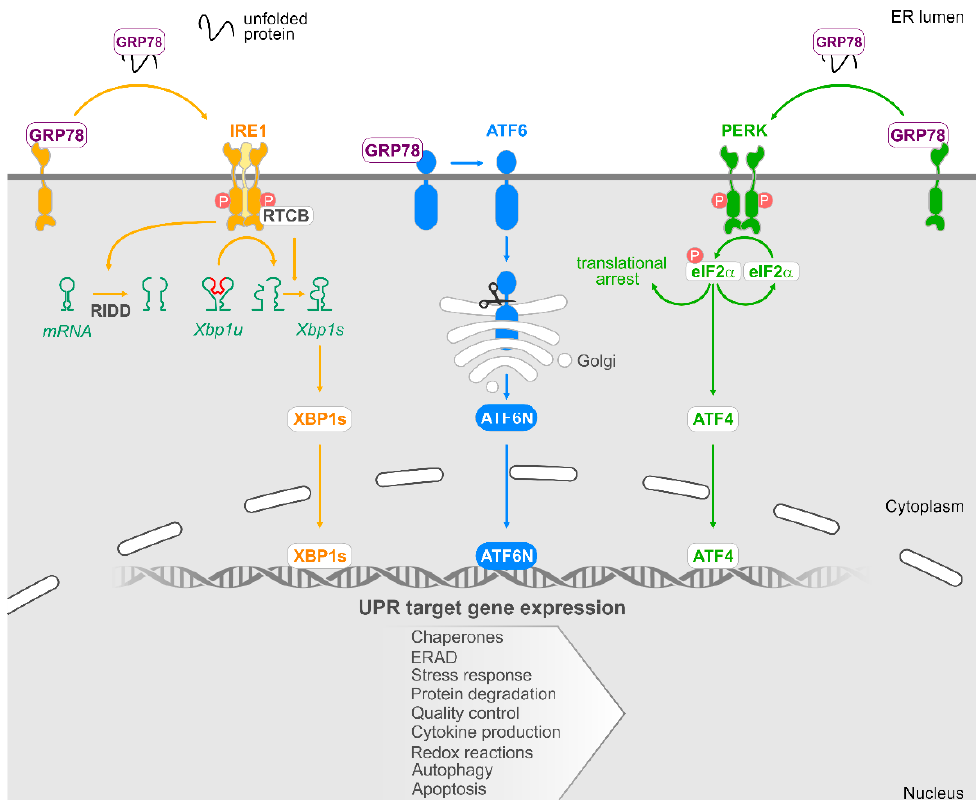
Figure 1. The unfolded protein response. Accumulation of unfolded proteins within the ER lumen leads to the dissociation of GRP78 from three ER stress sensors IRE1, PERK and ATF6, and their subsequent activation.Activation of IRE1 results in the removal of a 26 nucleotide intron from XBP1u mRNA. RTCB acts to ligate the mRNA, and this product is translated into the transcription factor XBP1s. Additionally, activated IRE promotes regulated IRE1 dependent decay (RIDD). RIDD activity of IRE1 is responsible for the cleavage of a subset of RNAs/miRNAs. When ATF6 is activated, it is cleaved in the Golgi to form an active transcription factor ATF6N. Upon activation, PERK phosphorylates eIF2 α , and this results in the attenuation of global translation. However, the transcription factor ATF4 is active, and it acts to upregulate a subset of genes. The transcriptional programme mediated by XBP1s, ATF4 and ATF6N promotes expression of chaperones, components of ER associated protein degradation (ERAD), increased ER capacity and reduced protein translation to ameliorate ER stress and restore homeostasis. Additionally, UPR-mediated gene expression also directly impact autophagy, cytokine production and apoptosis.